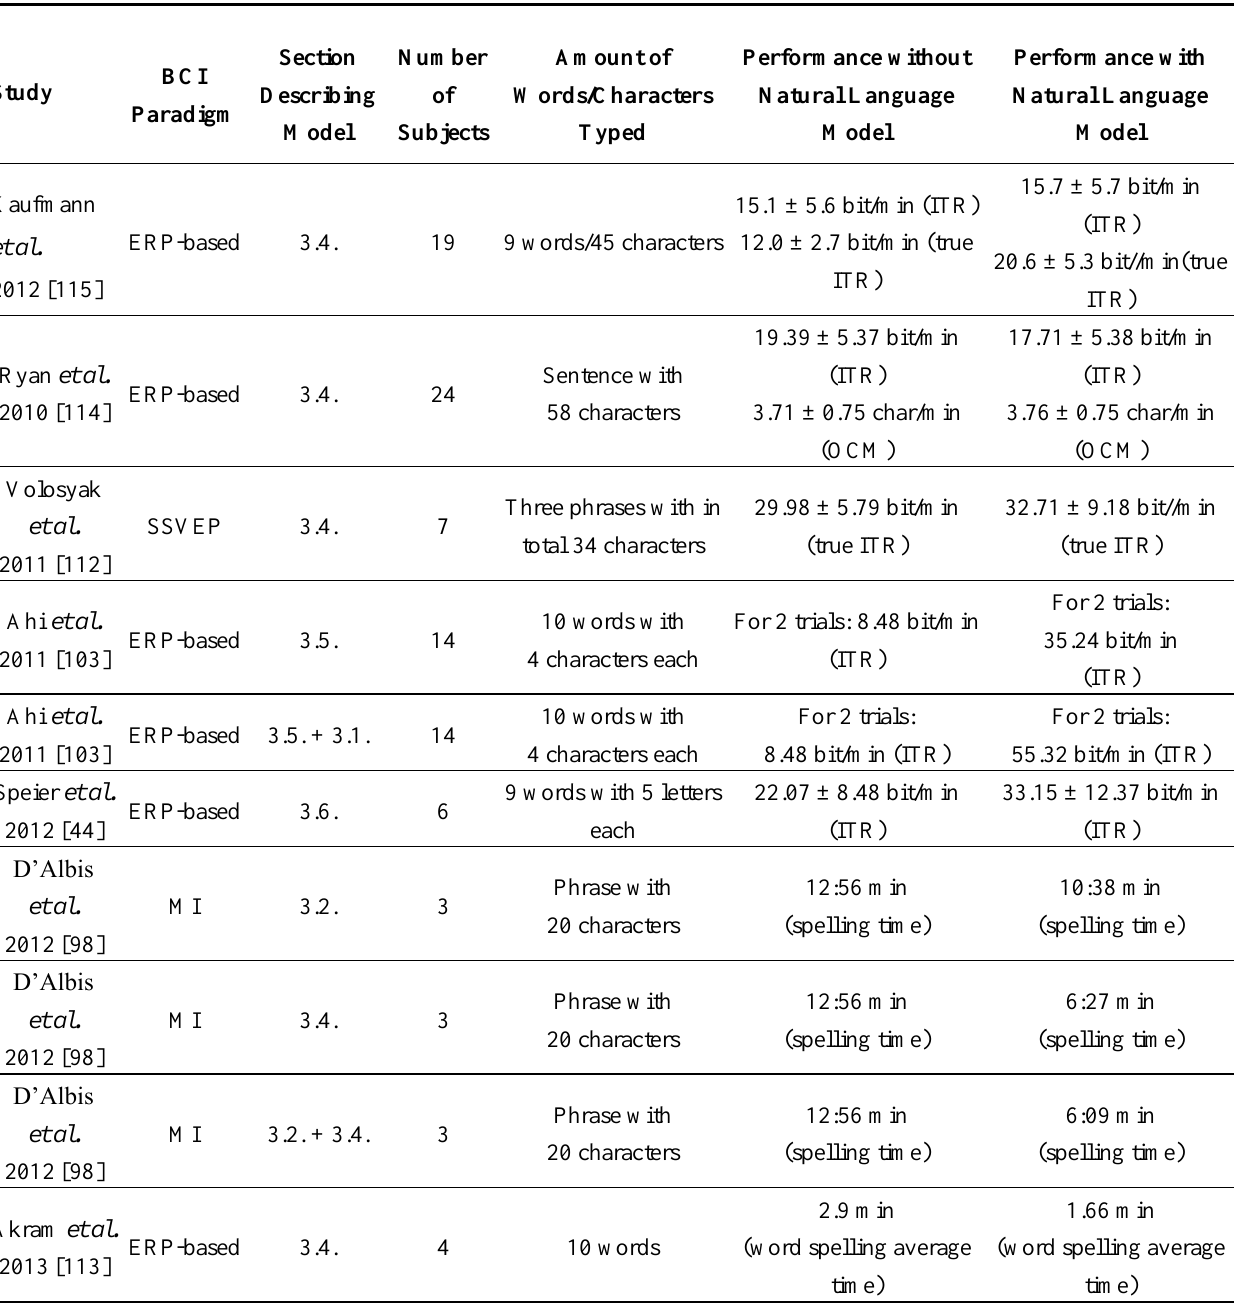
Table 1. Difference in performance of spelling interfaces with and without natural language models. The third column refers to the sections where they are